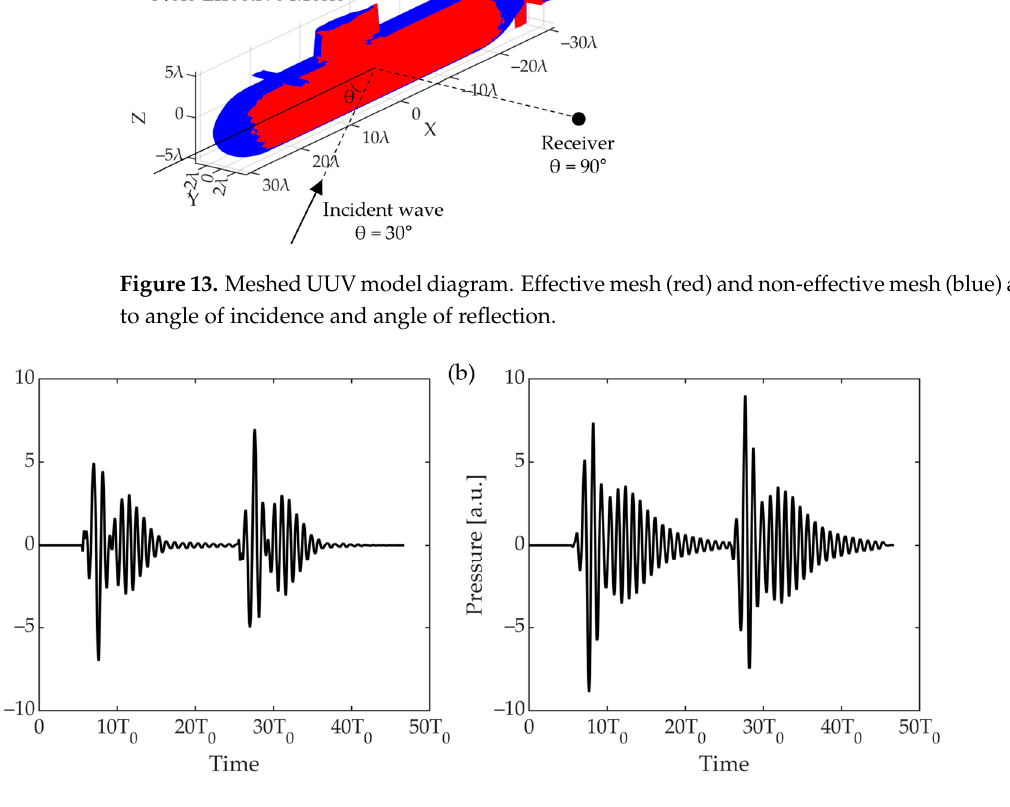
Figure 14. A-Scan that combines raw data received through active reflection control in the active mesh of the UUV model; ( a ) cymbal transducer; ( b ) stack